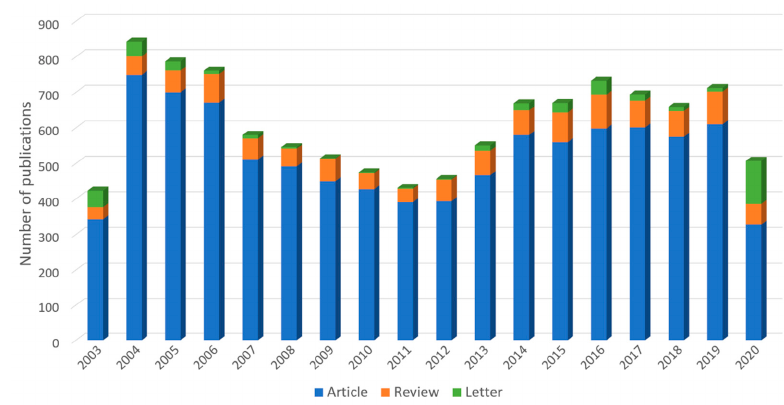
Figure 1. The trend of annual publications on the research of coronavirus during 2003–2020.